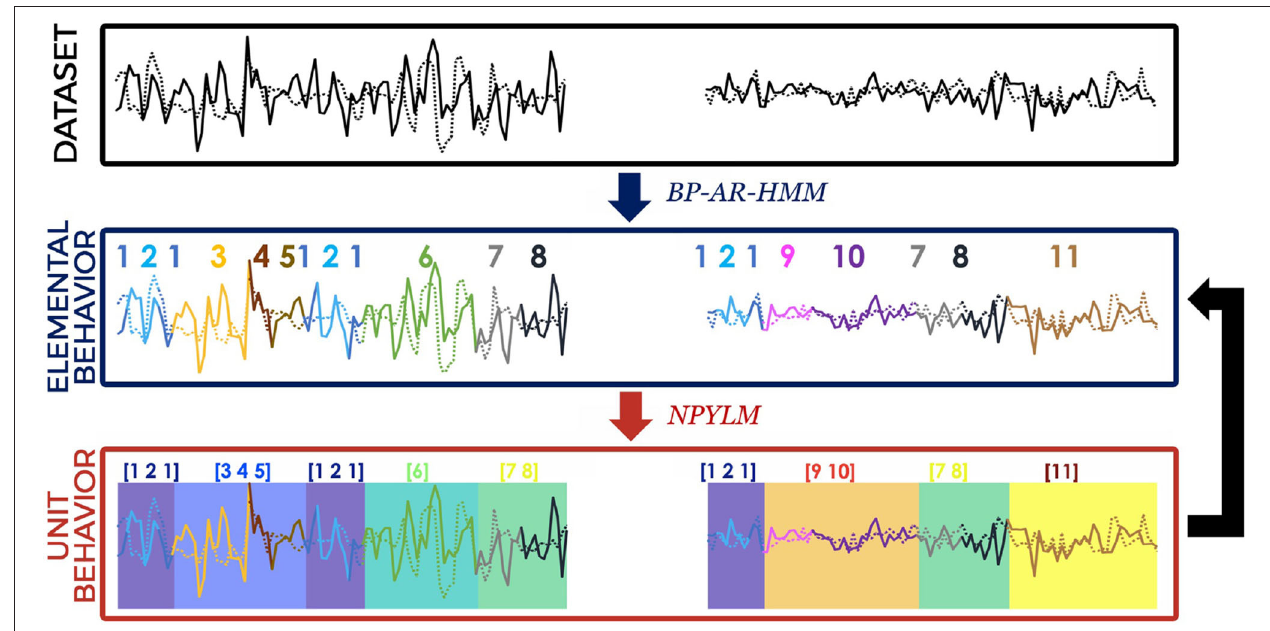
FIGURE 1 | Illustration of processing steps in our proposed method. Each time step is assigned both an EB label (line color) and UB label (background color). The summarized sequence of EB labels (shown as numbers above the lines) obtained from BP-AR-HMM are then grouped together (indicated by the square brackets) using